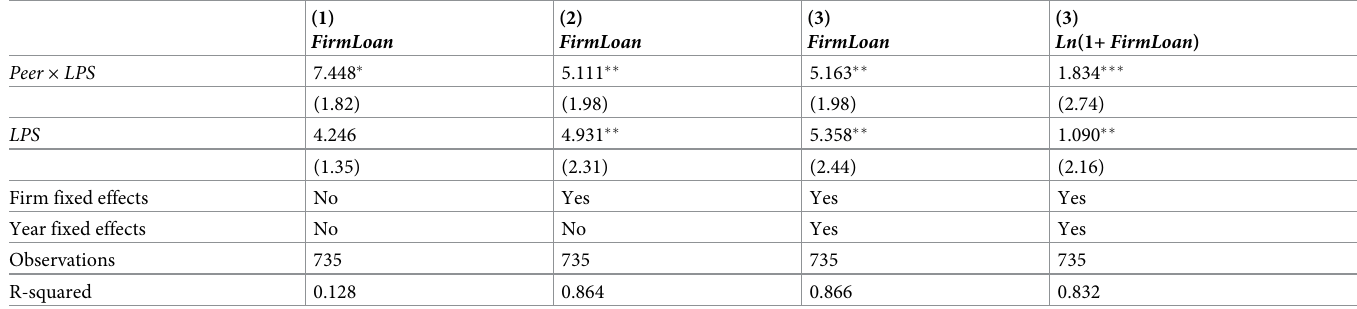
Table 5. The largest private shareholder and bank loans to firms in the their industry. This table reports the estimation results from OLS regressions analyzing the impact of the bank’s largest private shareholder on the bank’s loans to firms in the their industry, with a different combination of fixed effects in each column. Columns 1–3 uses FirmLoan as the dependent variable. Columns 4 uses Ln (1+ FirmLoan ) as the dependent variable. Variables are defined in S1 Appendix. The sample period is from 2007 to 2020. In parentheses are t-statistics. ��� , �� , � indicate statistical significance at the 1%, 5%, and 10% level,